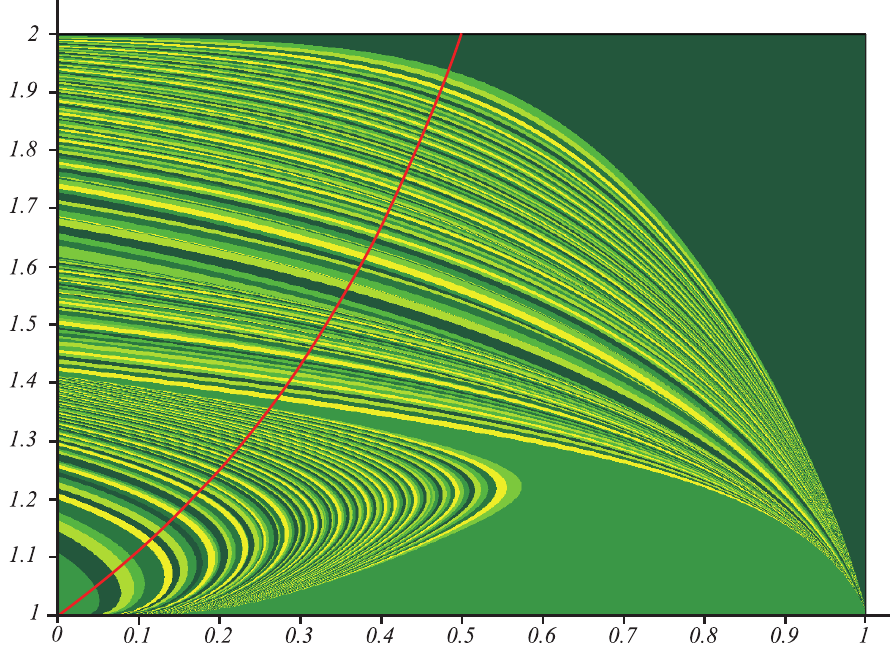
Fig. 5 The kneading chart for map T c , ε shows that the topological entropy as the function of c has a single minimum for ε in the interval [ 0 , 0 . 6 ] (more precise calculation gives ε ∈ [ 0 , 0 . 76 ] ). Above the red line one has that T c , ε is expanding ( DT c , ε > 1 ) , and there the topological entropy is monotone increasing in c